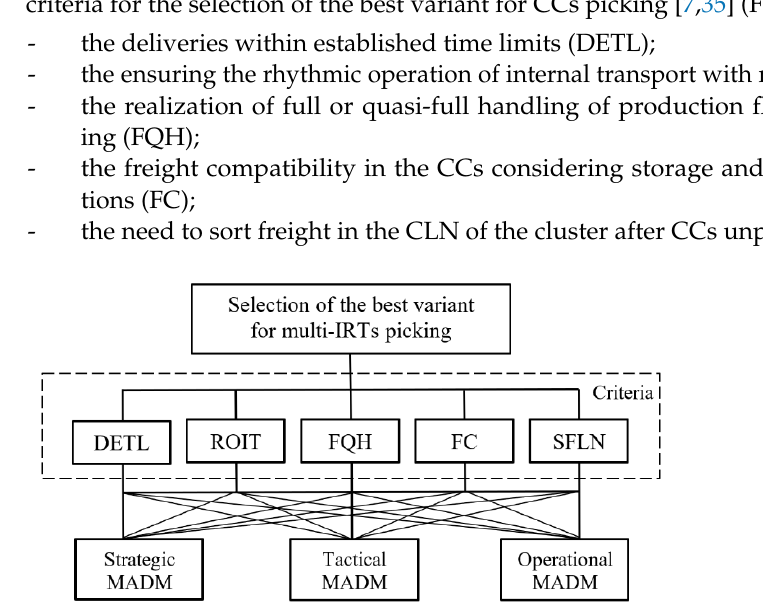
Figure 4. Selection of the best variant for CCs picking.